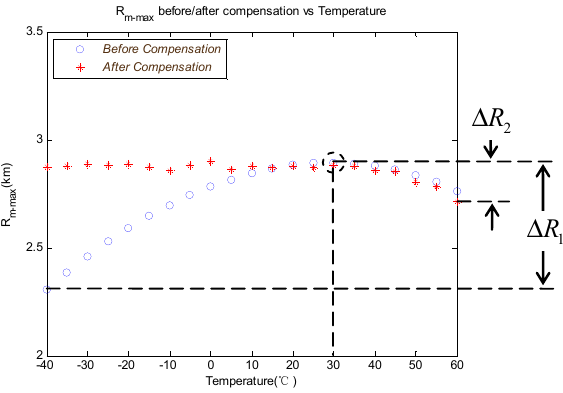
Figure 13. Comparison of the R M _ MAX under different ambient temperatures before and after compensation.